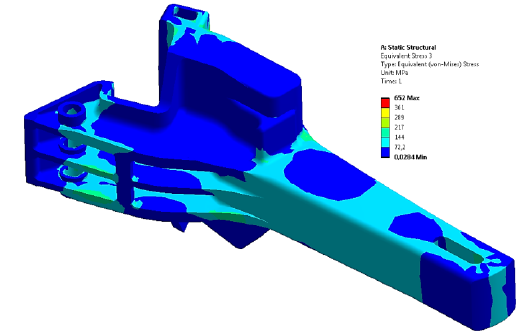
Figure 3. Equivalent stress distribution field, stretching, displacement of the axis of an adjacent automatic coupling 0.1 m below the considered, MPa